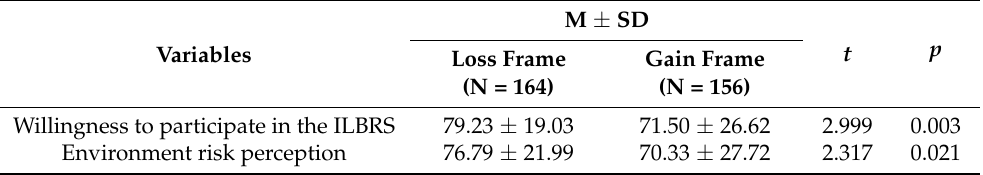
Table 2. Difference test of the willingness to participate in the ILBRS and the perception of environ- mental risks under the gain and loss